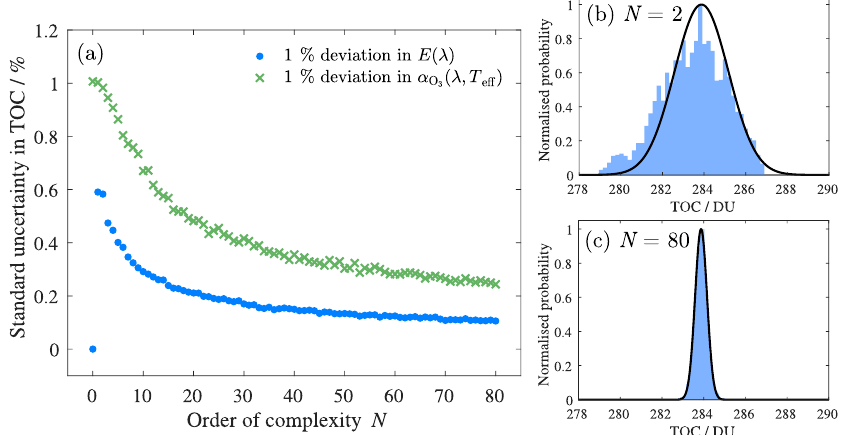
(λ,T eff ) plotted as 3 √ √ √ 3 1 / 3 1 / 3